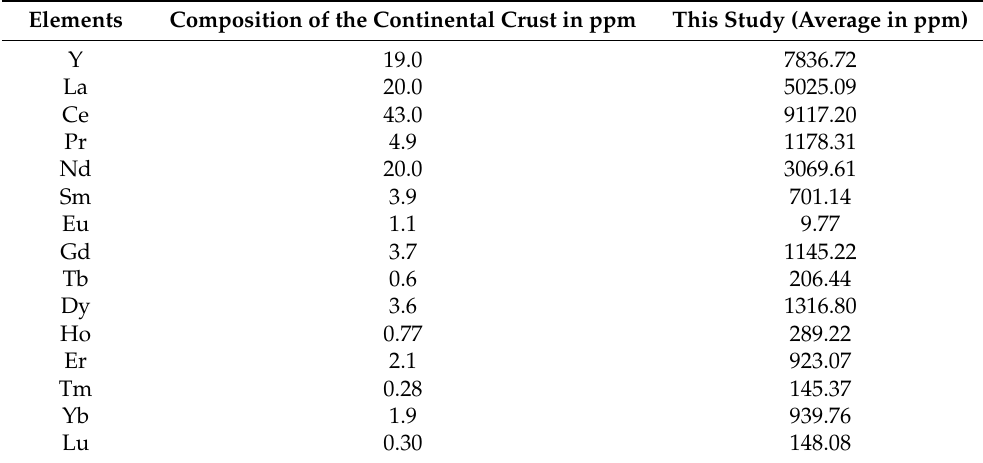
Table 8. A comparison of average REE content in tailing from Bangka Island to average REE in the bulk continental crust